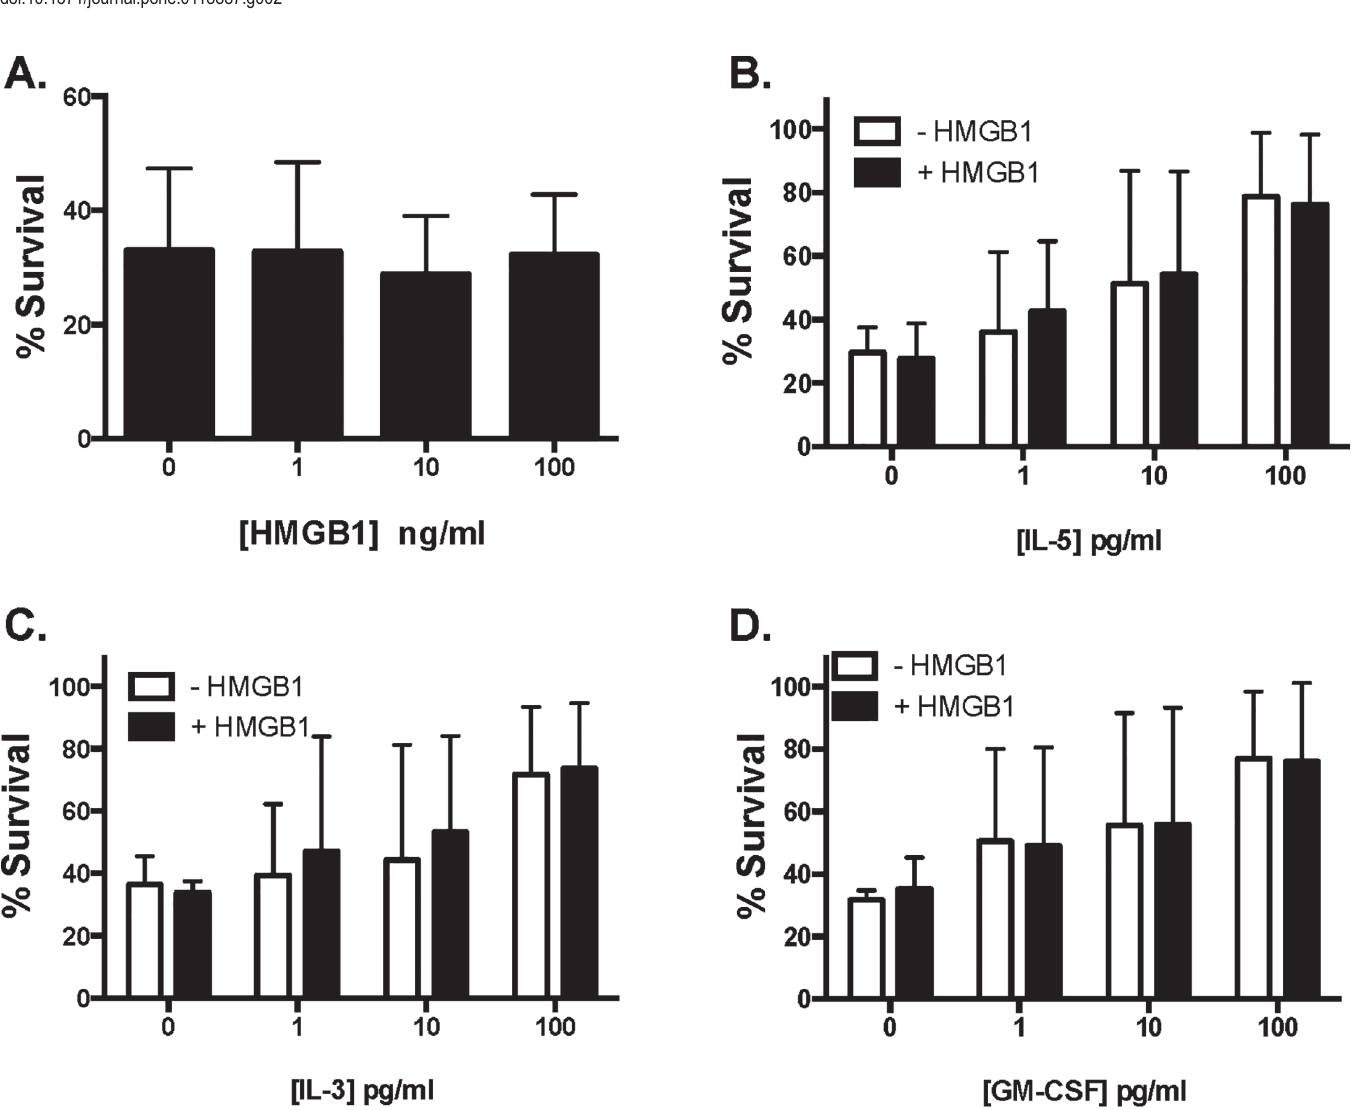
Fig 3. HMGB1 has no impact on eosinophil survival ex vivo . Eosinophils isolated from peripheral blood of normal donors incubated with (A) HMGB1 alone or 10 ng/mL HMGB1 in combination with increasing concentrations of pro-survival cytokines (B) IL-5, (C) IL-13 or (D) GM-CSF for 48 hours and then evaluated with Violet live-dead for the assessment of viability.